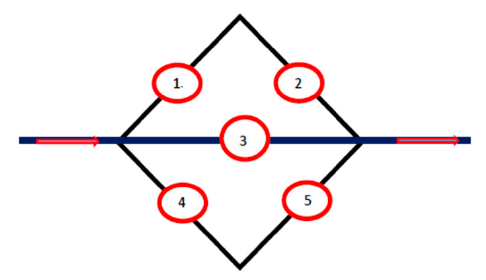
Figure 2. Block diagram of the bridge system.